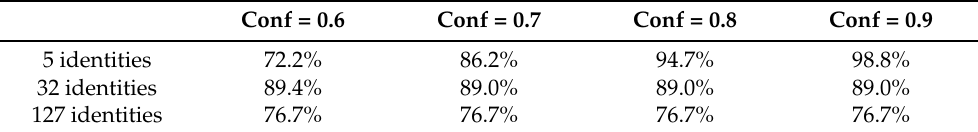
Figure 10. Precision–Recall curves in different scenarios of our proposed methods. Table 11. Open-set face recognition accuracy with the FaceNet+SVM on